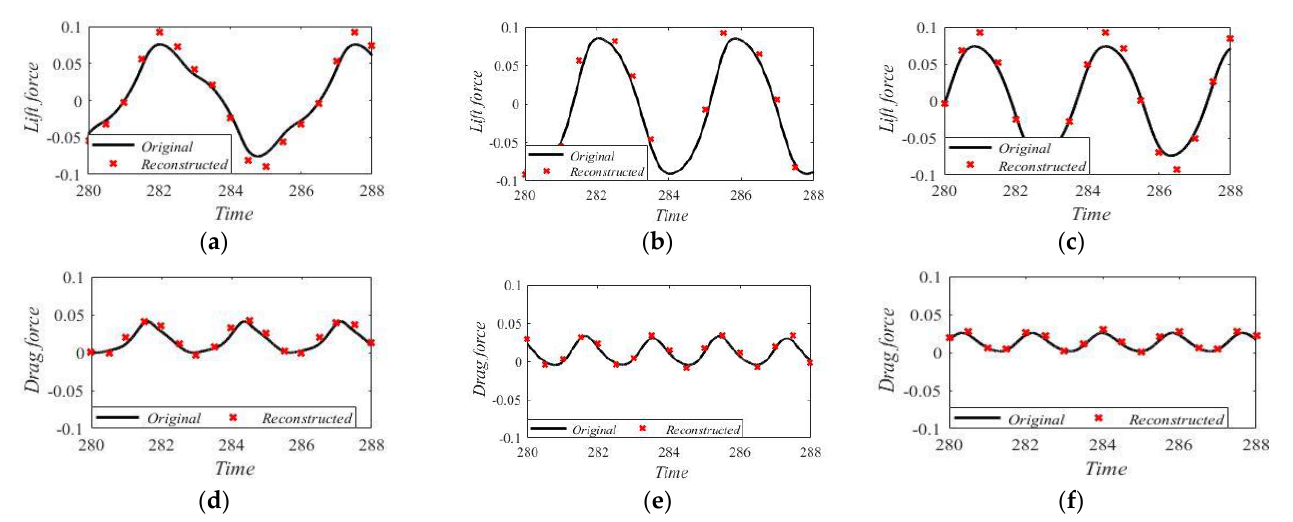
Figure 22. Time histories of (a – c ) the DC lift coefficient and ( d – f ) drag coefficient obtained by the simulation results and reconstructed by using the selected DMD modes for 𝐿/𝐷 = 1.8, 2.5 and 3 : ( a , d ) 𝐿/𝐷 = 1.8 ; ( b , e ) 𝐿/𝐷 = 2.5 ; ( c , f ) 𝐿/𝐷 = 3 .